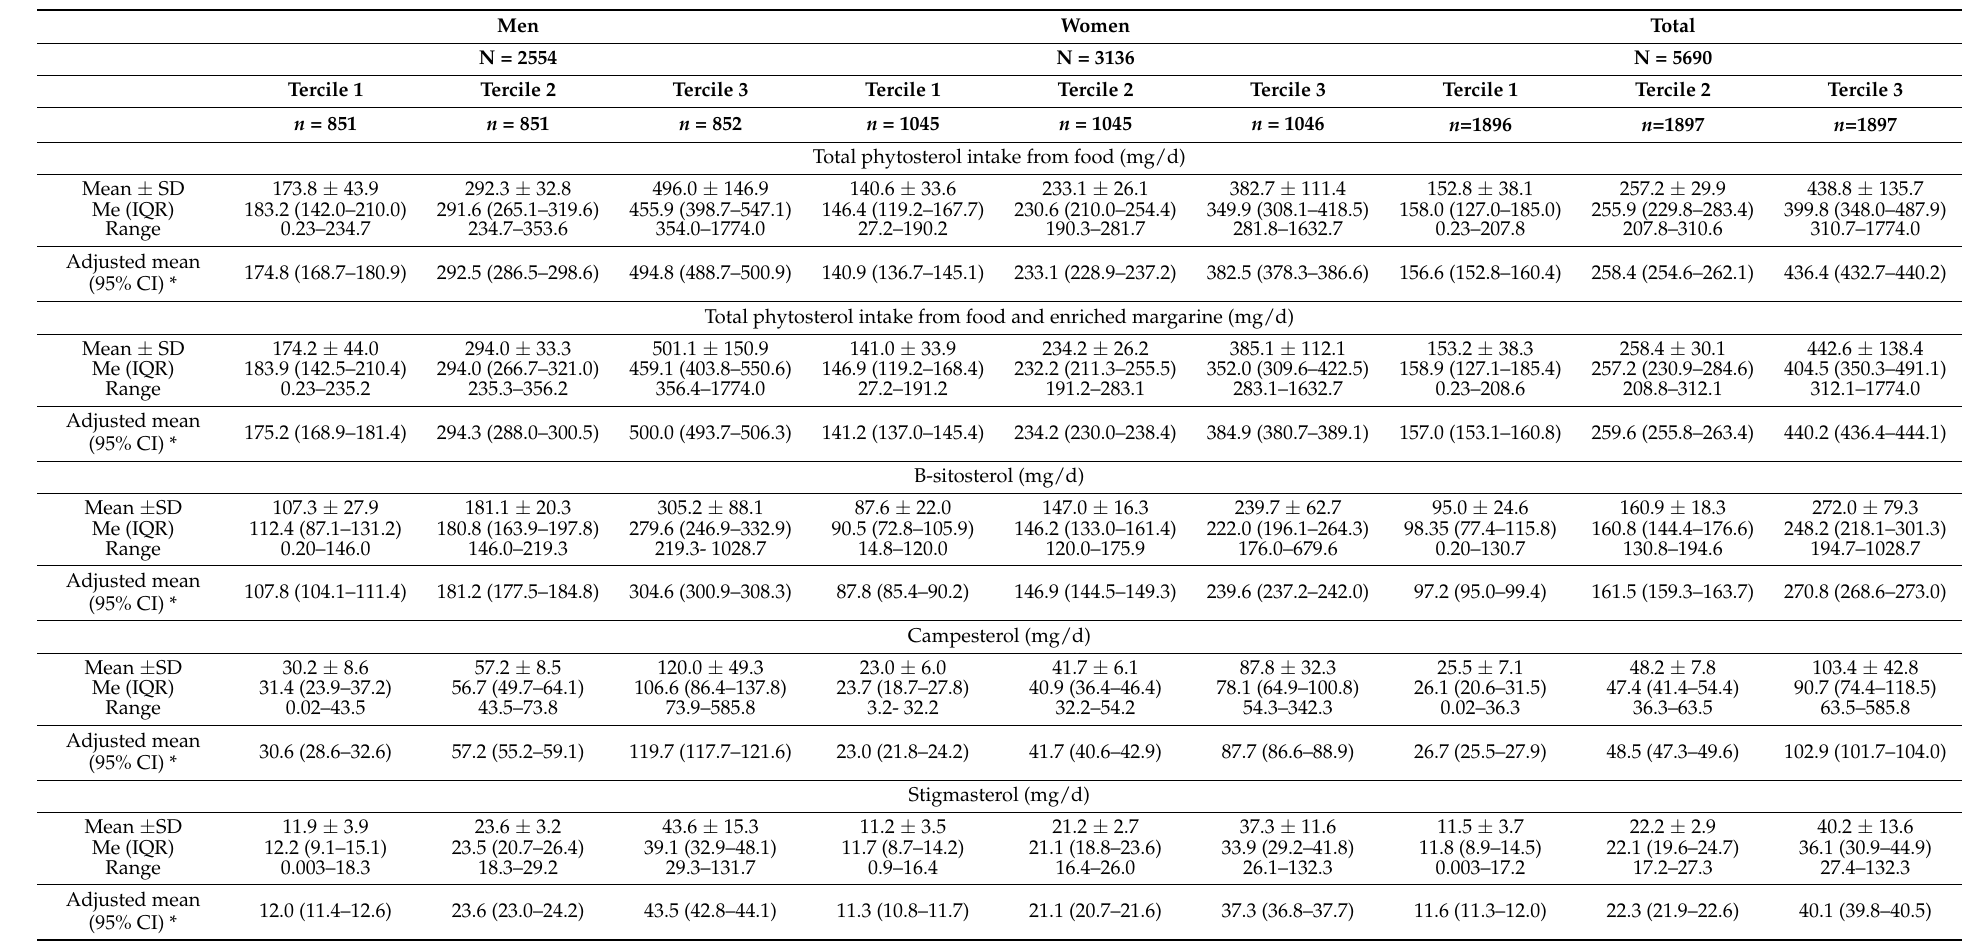
Table 3. Intake of phytosterols in